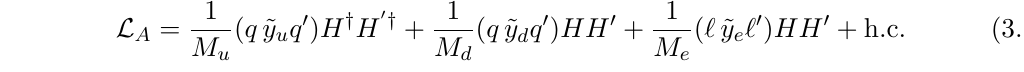
(cid:1) 1 and H 2 (cid:0)